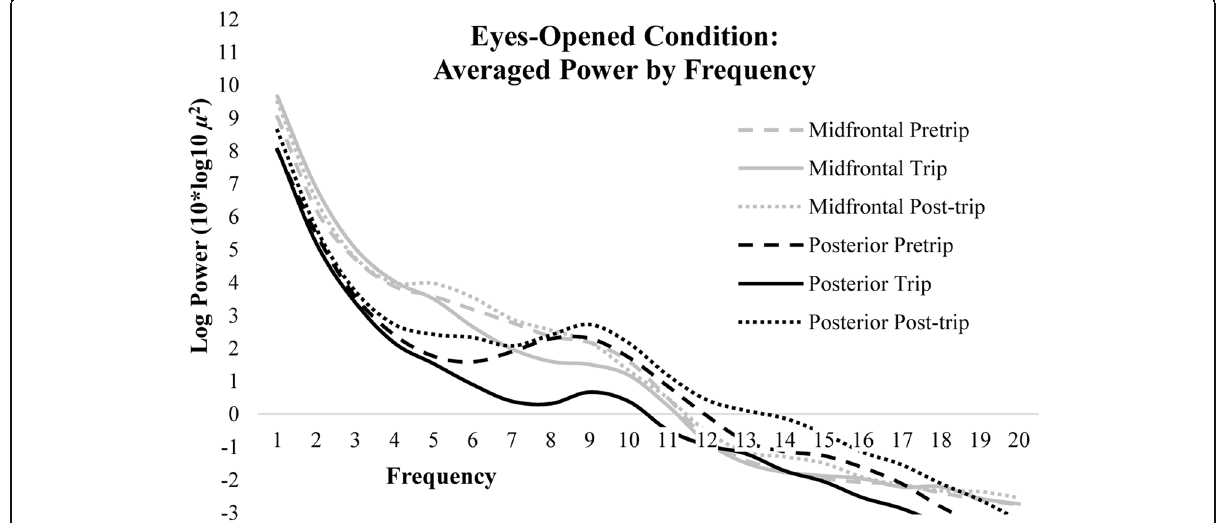
Fig. 3 Spectra for each session averaged across midline and posterior electrodes during the eyes-opened